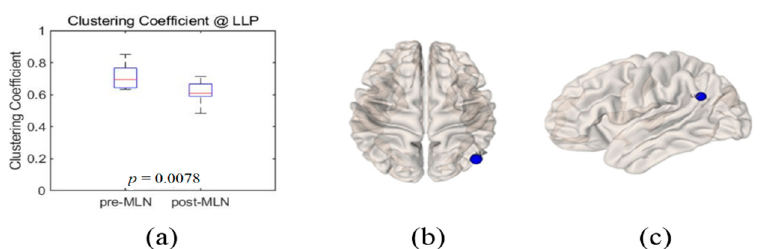
Figure 2. Illustrations of clustering coefficient change at left lateral parietal cortex as the functional connectivity of neural network in fibromyalgia patients’ brains due to Milnacipran drug therapy. ( a ) Boxplots (left: before medication, right: after medication) of the distribution of the clustering coefficient at left lateral parietal cortex. This position is indicated by blue ‐ colored small disk on 3D brain surface in ( b ) transverse and ( c ) lateral views. Blue color markers imply that the clustering coefficient statistically decreased due to drug therapy.